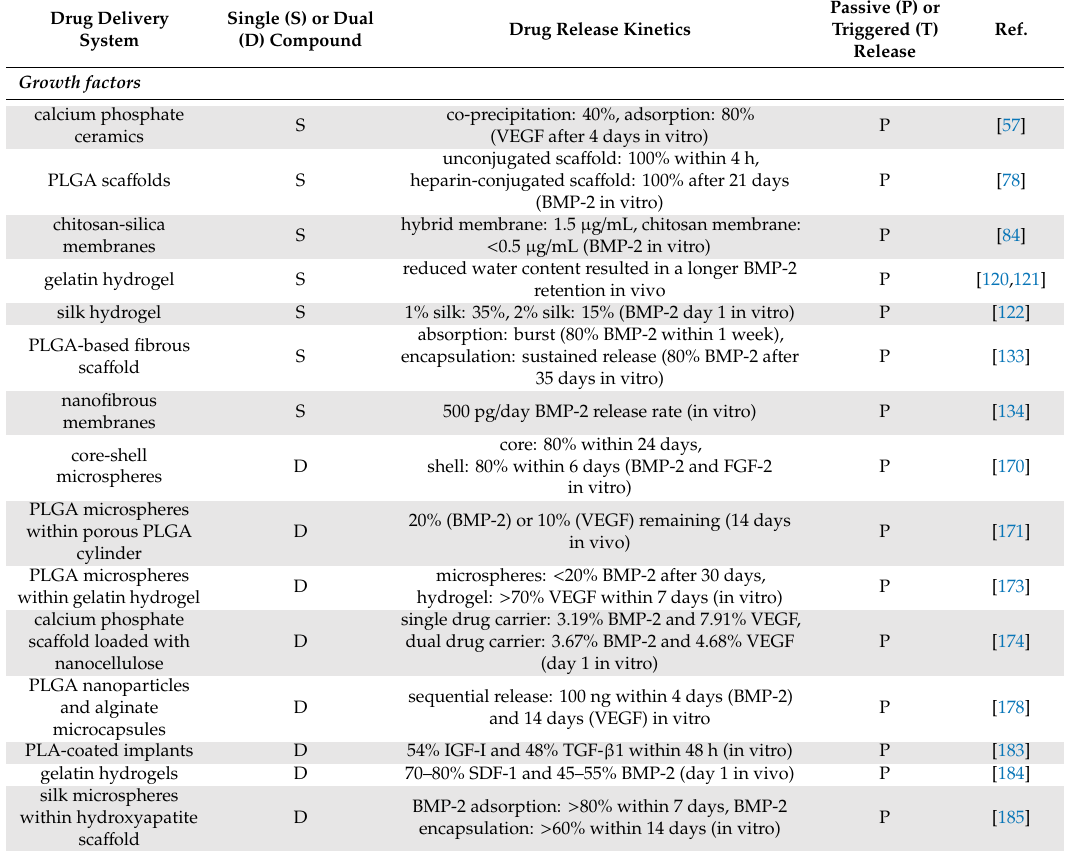
Table 2. Overview of representative studies providing kinetic data obtained from use of single or dual compound delivery systems and passive or triggered drug